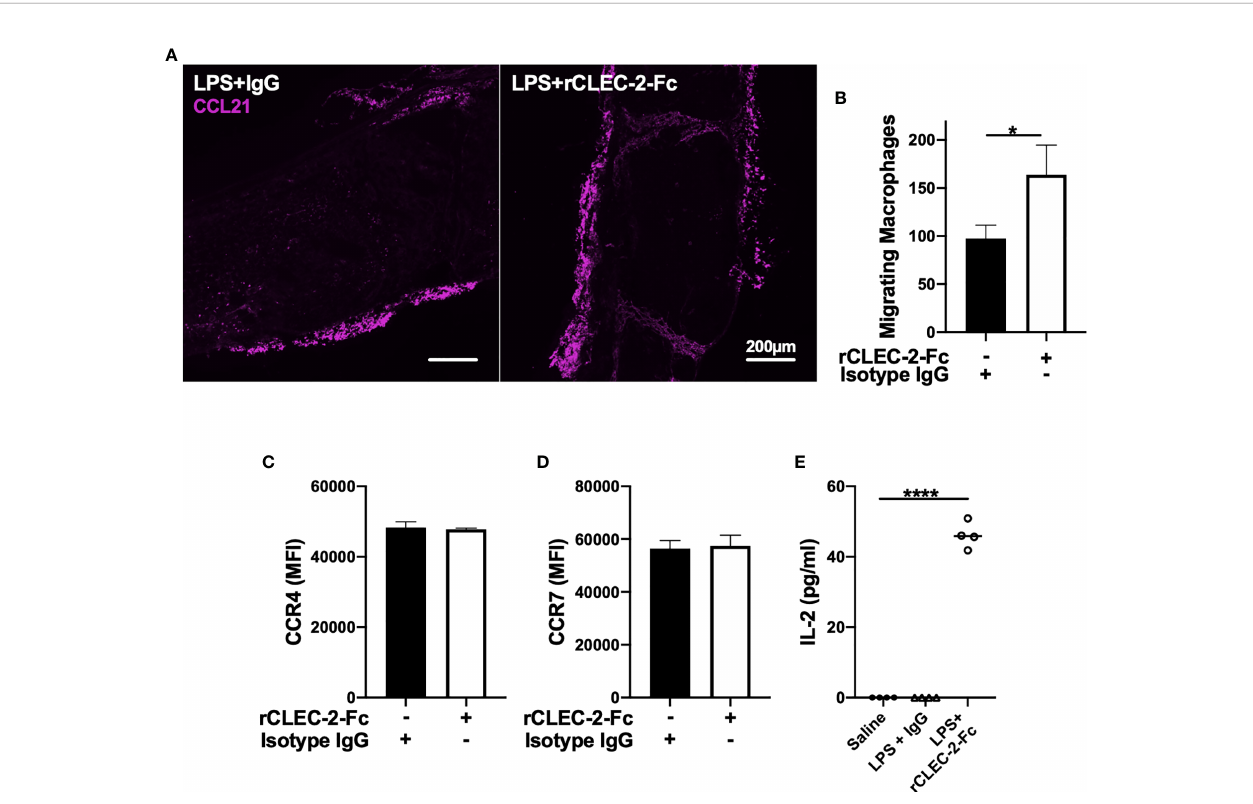
FIGURE 6 | rCLEC-2-Fc increases in fl ammatory macrophage migration towards CCL21 and primes T cells in mesenteric lymph nodes. WT mice were intraperitoneally injected with LPS (10mg/kg) for 18h followed by rCLEC-2-Fc or IgG isotype control (100µg/mouse) for an additional 4h (n=4). (A) Immuno fl uorescent staining of CCL21 (purple) in frozen MLN taken from LPS-challenged mice. (B, C) 24h LPS-stimulated (1µg/ml) BMDM were treated with rCLEC-2-Fc (10µg/ml) or IgG isotype control (10µg/ml) for 4h. Surface expression of (B) CCR4 and (C) CCR7 median fl uorescence intensity (MFI) was detected by fl ow cytometry (n=4). (D) Migration of in fl ammatory BMDM co-cultured with rCLEC-2-Fc or IgG Isotype control (10µg/ml) toward CCL21 (30ng/ml) was analysed using a Boyden chamber assay for 4h (n=3). (E) IL-2 secretion from MLN cells isolated from different mice cultured in vitro with LPS (10ng/ml) for 16h was quanti fi ed by ELISA.The statistical signi fi cance was analyzed using a Kruskal-Wallis multiple comparisons test. * p <0.05, **** p